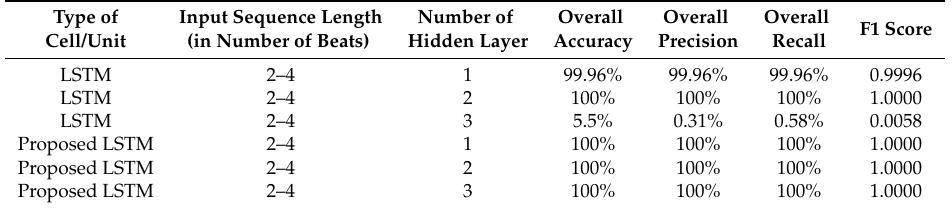
Table 5. Performance summary of the proposed bidirectional LSTM in NSRDB analysis 2 of Figure 8b.